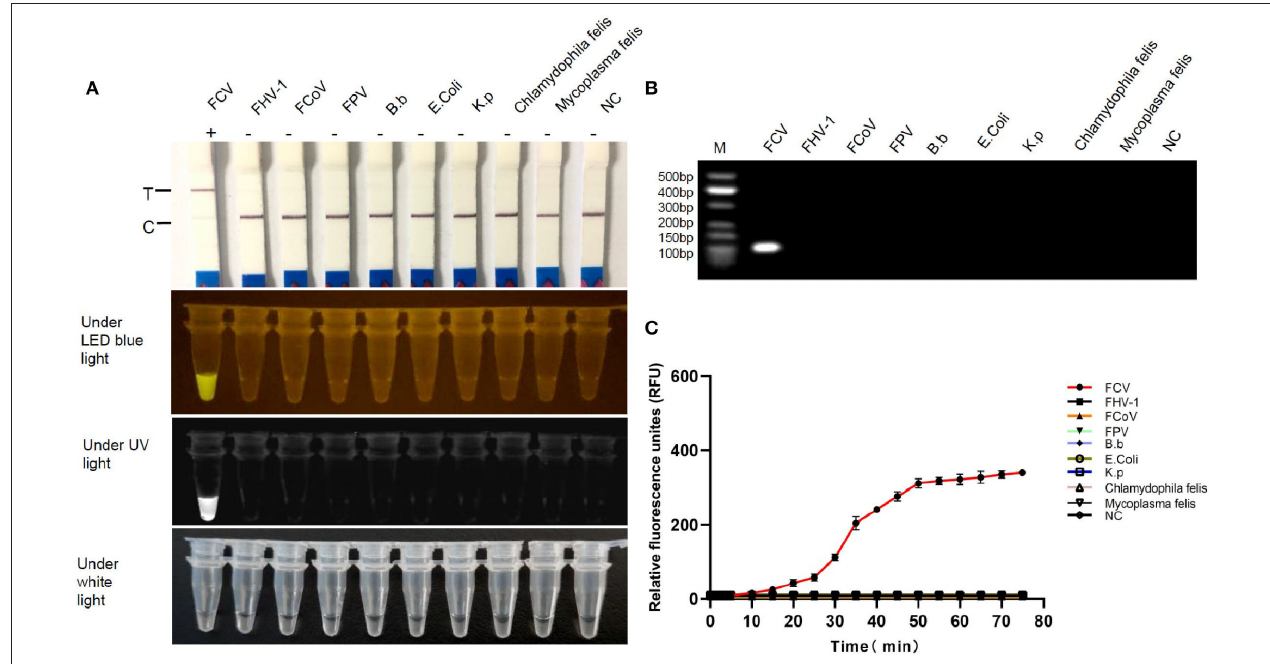
FIGURE 5 | Specificity testing of FCV-Cas13a assays. (A) Detection results of FCV-Cas13a-LFD and FCV-Cas13a-FLUOR. Both methods only detected FCV RNA but no other pathogens. (B) Electrophoresis of RPA amplicons of all tested pathogens. Lane M, standard molecular weight; lane NC, negative control (RNase-Free distilled water). (C) Detection results by FCV-Cas13a-FLUOR were shown in fluorescence plottings. Each experiment was repeated three times.